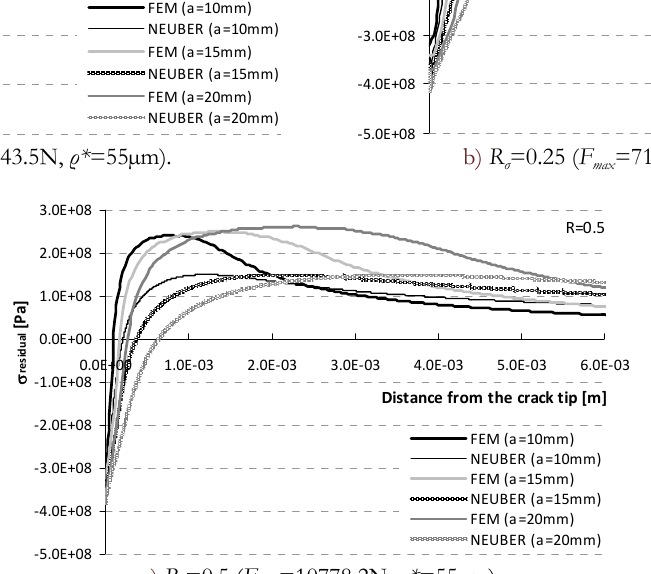
Figure 13: Residual stress distribution ahead of the crack tip along the crack plane line (y=0) for CT specimens made of S355 steel: comparison between analytical and numerical results. Distinct stress ratios and crack sizes considered.